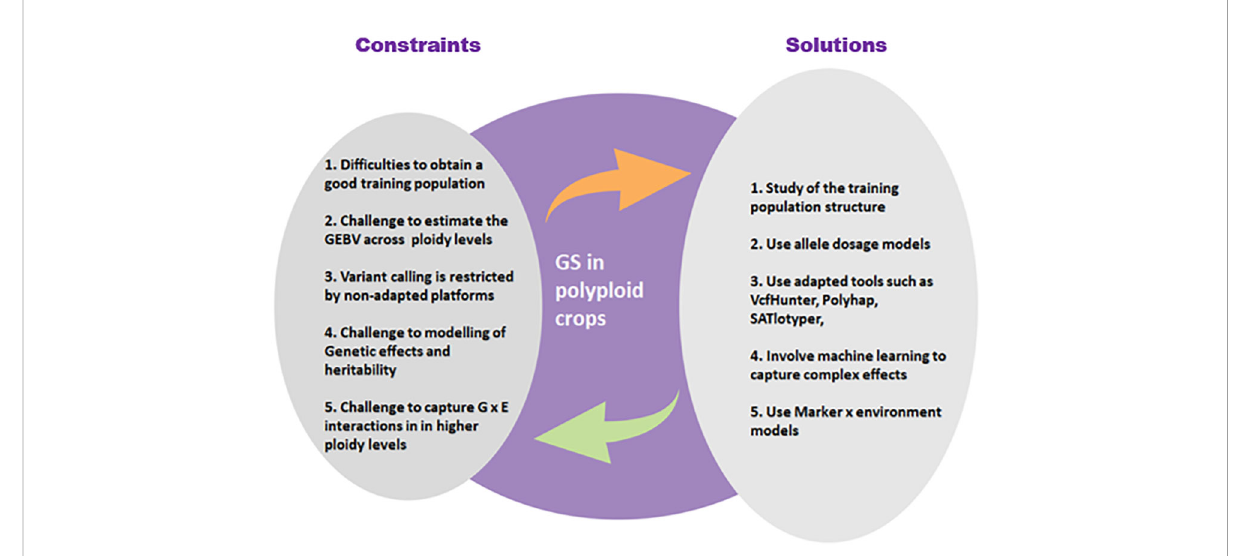
FIGURE 4 Main constraints of the application of GS in polyploid plants and possible solutions to these